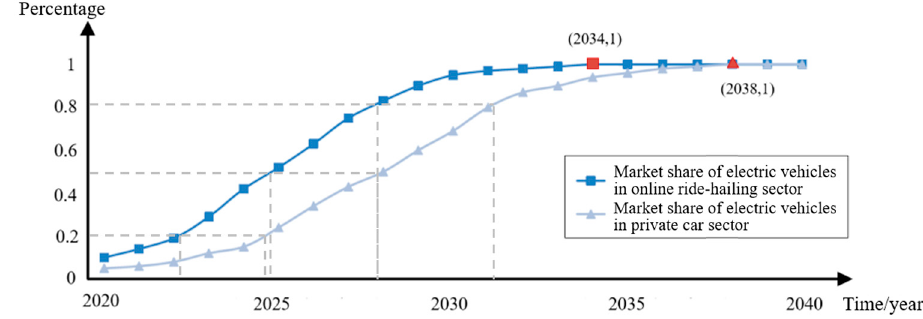
Figure 6. ABMS simulation result: market share of electric vehicles in online ride-hailing and private car sectors.